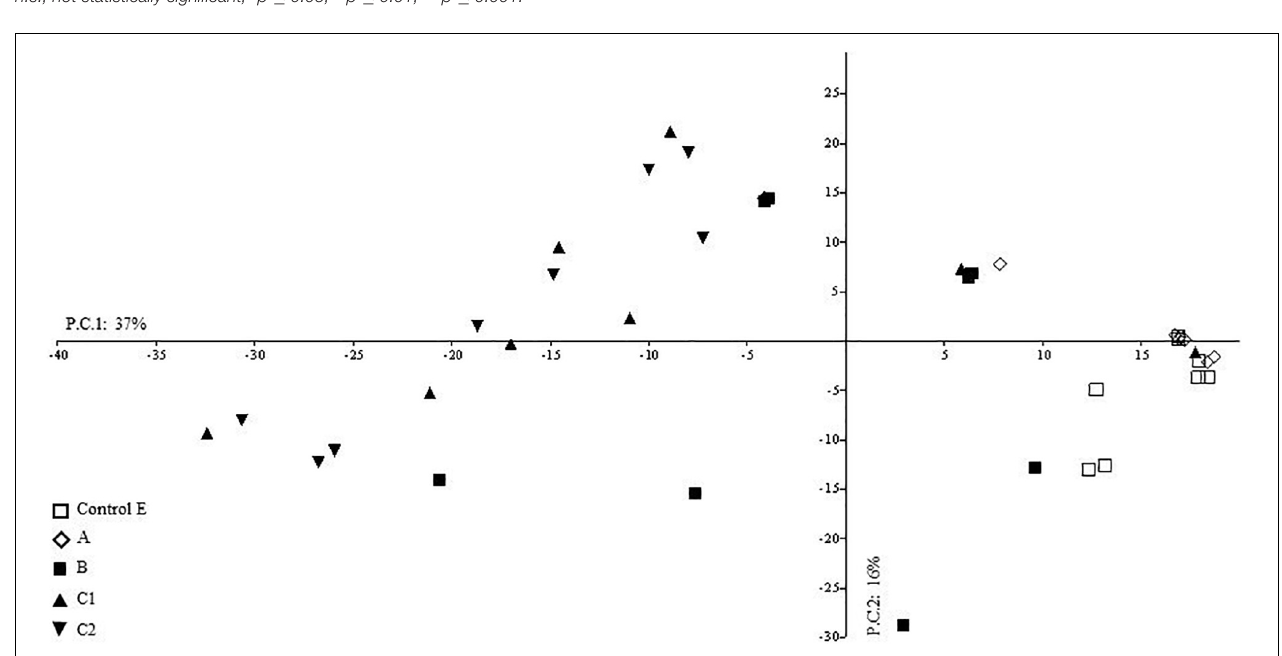
FIGURE 4 | Principal component analysis intermediate-long period after fire.